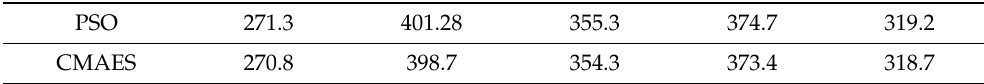
Table 3. Logged MSE values for PSO and